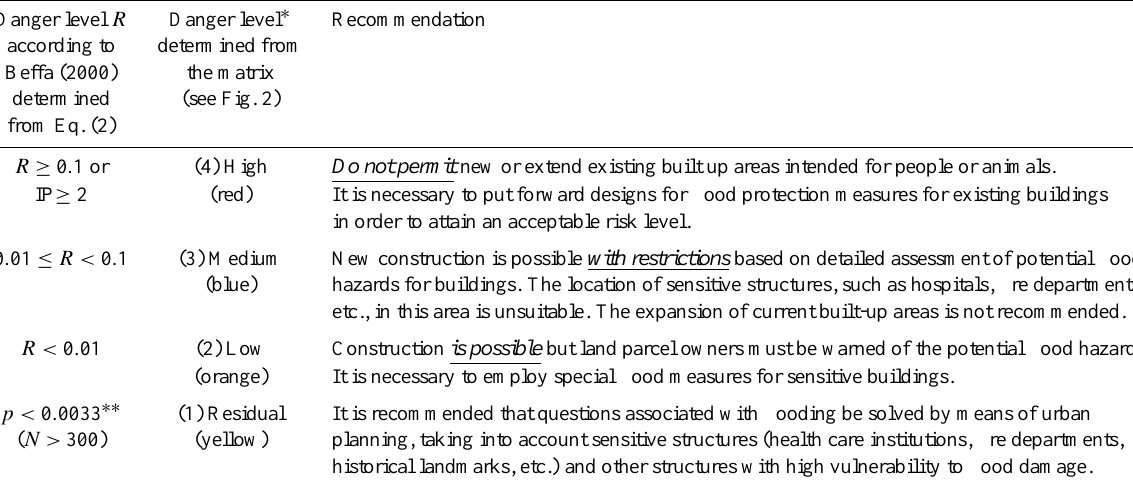
Table 1. Danger classification and verbal description consistent with (Zimmerman et al., 2005; FOWM, 1997).